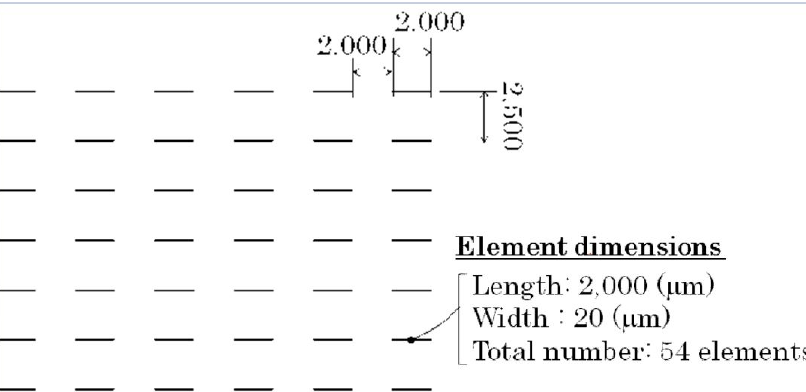
Figure 3. Layout of dispersed individual elements on a glass substrate.